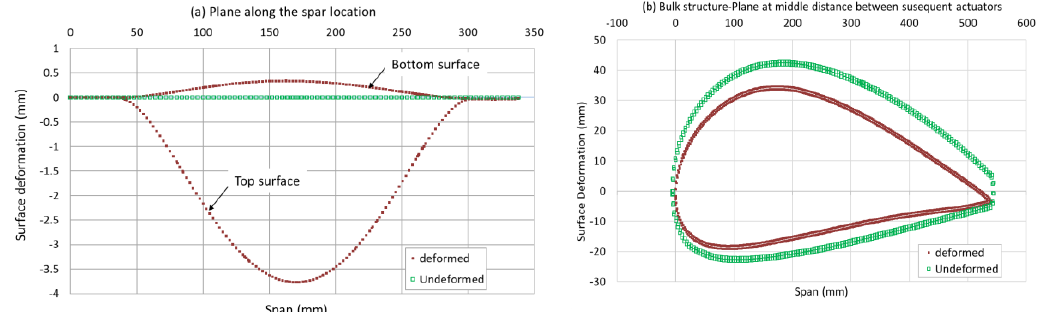
Figure 7. Wing model bulk material out-of-plane deformation for 1% camber rate.